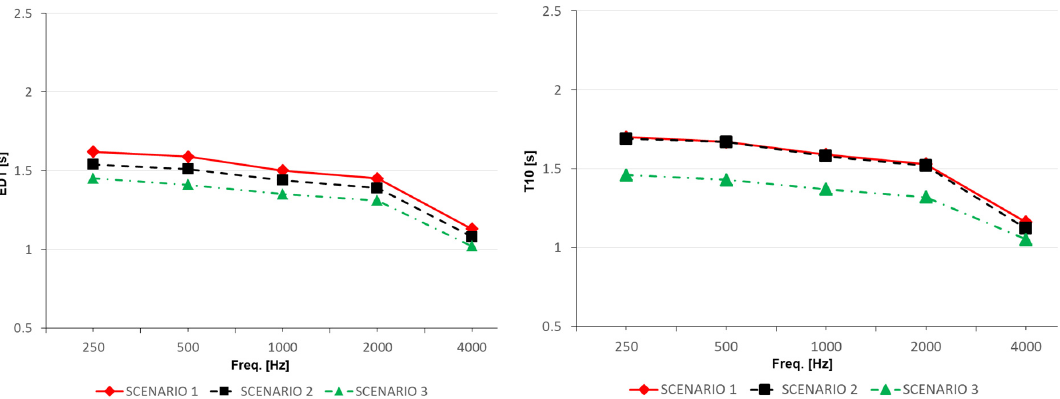
Figure 9. Averaged values of the simulated acoustic parameters (Early Decay Time (EDT) and T10) for the theatre in Scenario 1 (empty theatre), Scenario 2 (with the audience), and Scenario 3 (3D model reconstructed according to the plan dated 1784 in unoccupied condition).